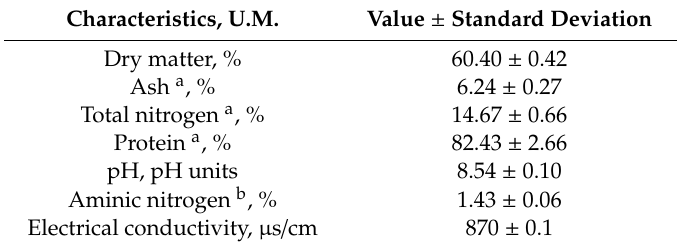
Table 1. Physico-chemical characteristics of concentrated collagen hydrolysate. Characteristics,